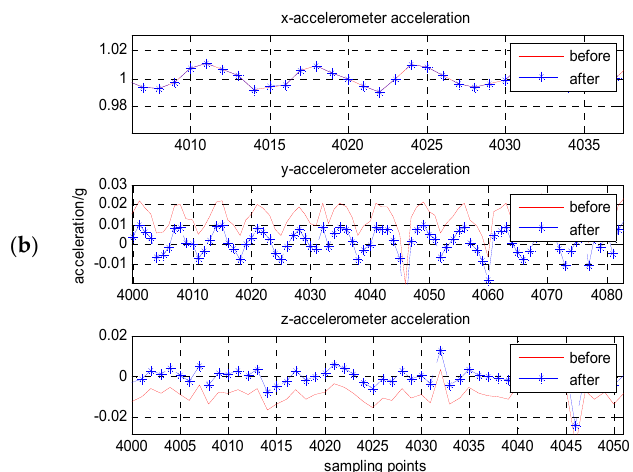
Figure 5. Contrast of three-axis acceleration before and after compensation when the x -axis, respectively, at ± 1 g position: ( a ) x -axis at − 1 g position; ( b ) x -axis at +1 g position. Table 1. Static calibration of accelerometer unit.